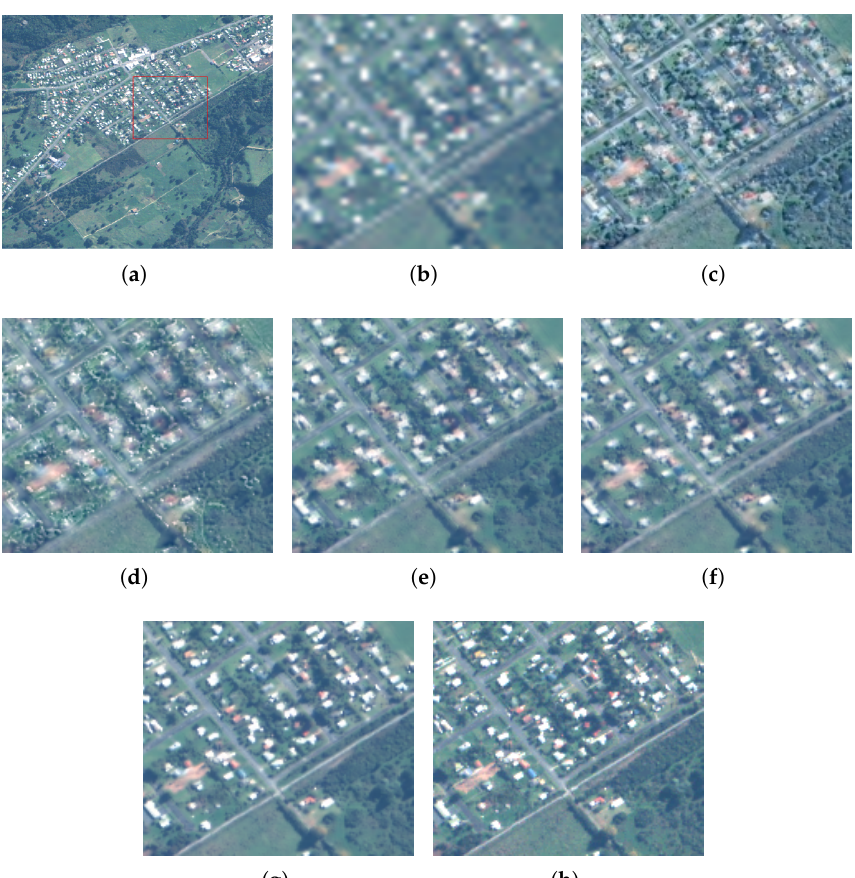
Figure 9. ( a ) Red rectangle area to be enlarged in the reference image. ( b – h ) are partial enlarged views of Figure 8a–g.